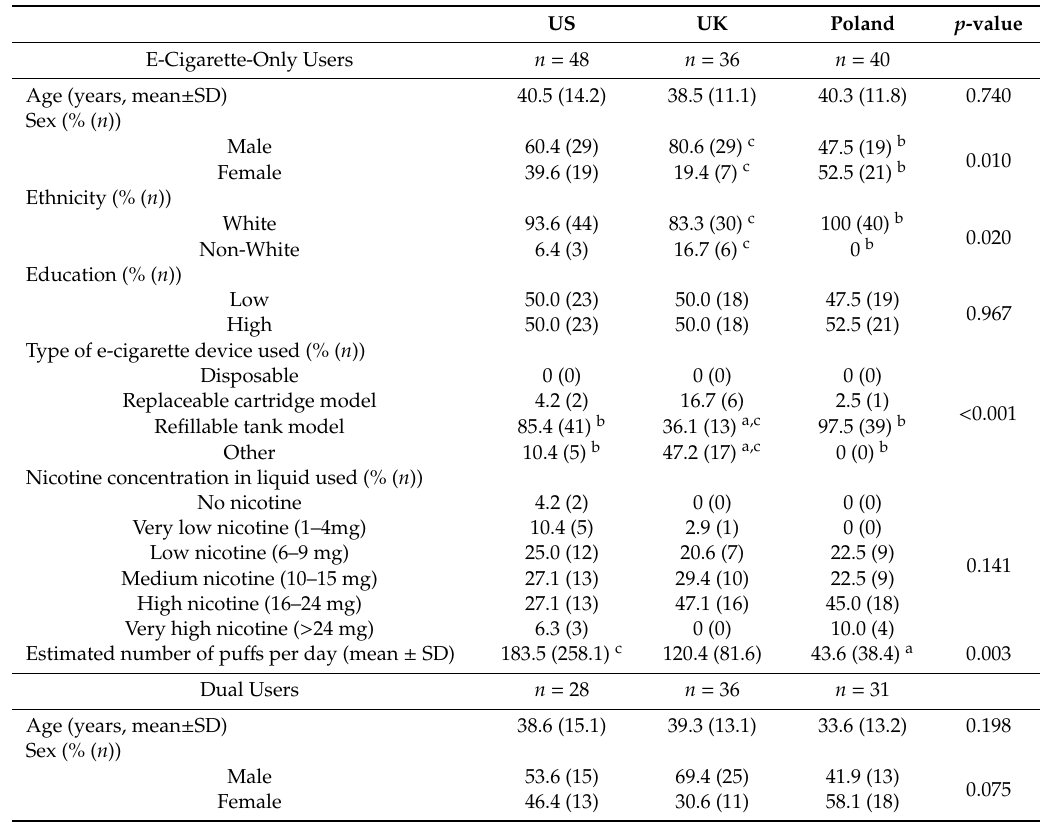
Table 1. Characteristics and pattern of tobacco product use among e-cigarette-only users ( n = 124), dual users ( n = 95), and cigarette-only smokers ( n = 127) from USA, UK, and